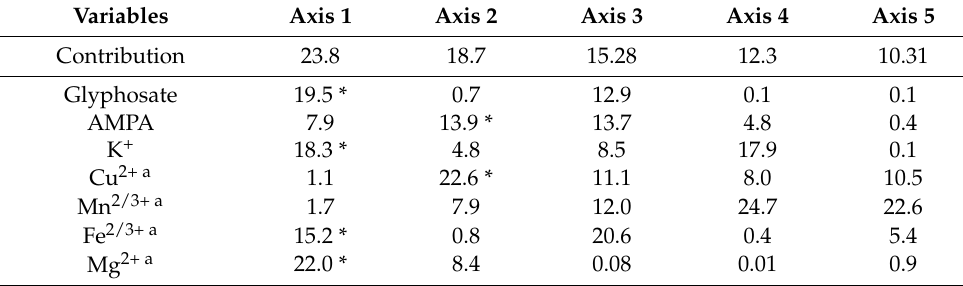
Figure 4. Average glyphosate and AMPA content based on the texture of clay (CT n = 10), loam (LT n = 15) and sandy loam (SLT n = 6) soils in May 2014 before sowing ( a , c ) and in October 2014, at harvest time ( b , d ). Boxplots represent the median, and the 25 and 75% quantiles. Circles ◦ represent potentially outliers. The detection frequencies of both compounds according to soil texture were represented by bar histograms before sowing ( e ) and at harvest time ( f ). The letters A and B represent the different significant groups. Table 4. Partial contribution of variables as %, representing the composition of soils derived from the PCA, according to the 5 axes chosen and representing 80.45% of total